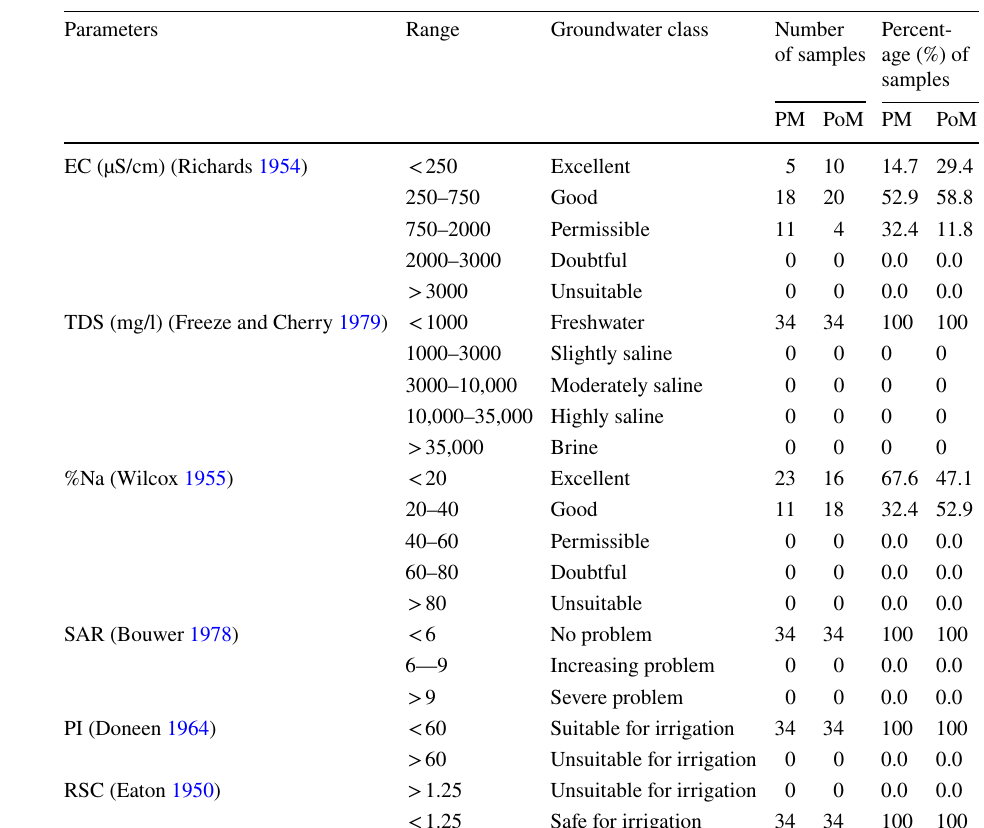
water quality indices during both PM and PoM